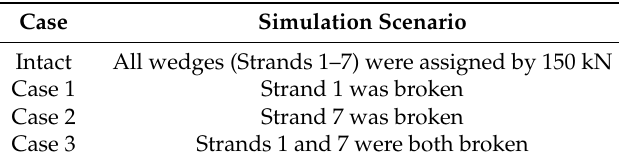
Figure 10. FE model of multi-strands anchorage embedded with hoop-type PZT interface. Table 4. Simulation cases of strand breakage in the FE model.